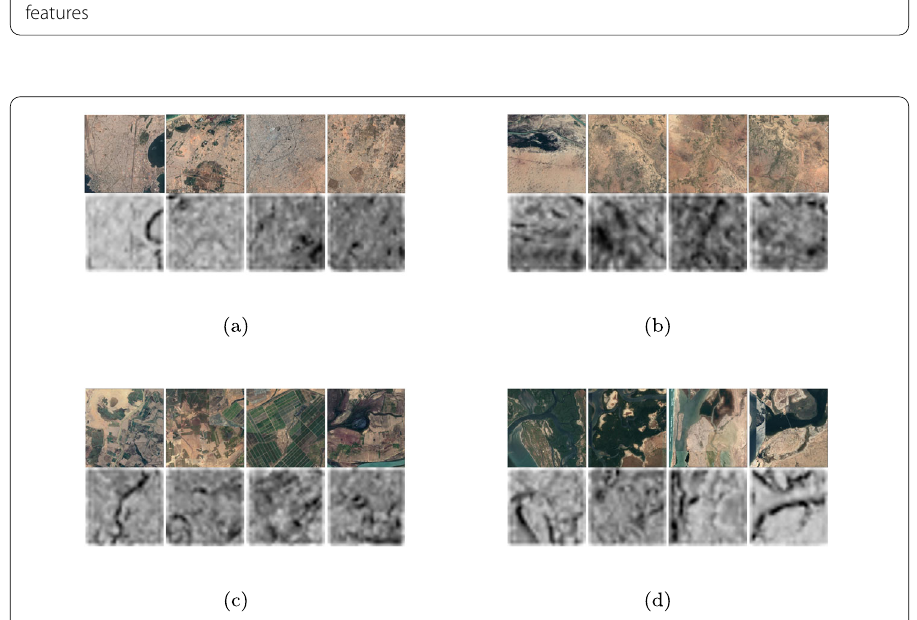
Figure 6 Visualizing the maximally activating Landsat images for four selected features extracted by the deep neural network. Each pair in each sub-figure shows the original Landsat image ( top ) and the corresponding activation map for a given feature ( bottom ). The four selected features appear to correspond to presence of ( a ) dense urban areas, ( b ) sparse rural areas, ( c ) agricultural land, and, ( d ) water bodies. See Additional file